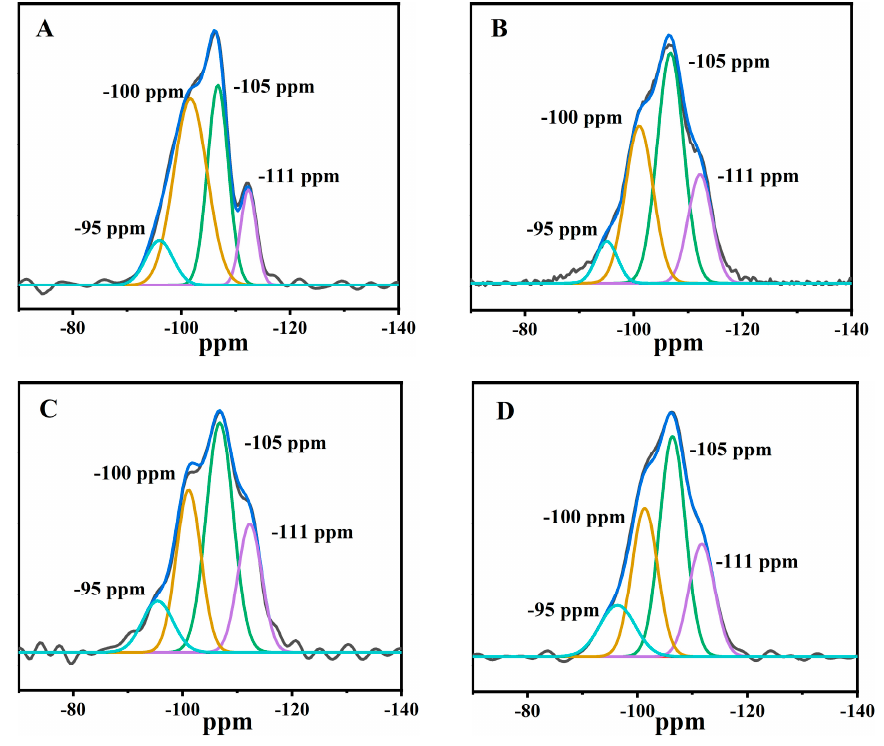
Figure 4. 29 Si-NMR patterns of CP ( A ), Fe(0.03) − H(0.05) − CP − 3 ( B ), Fe(0.03) − H(0.05) − CP − 9 ( C ), and Fe(0.03) − H(0.00) − CP − 9 ( D ).